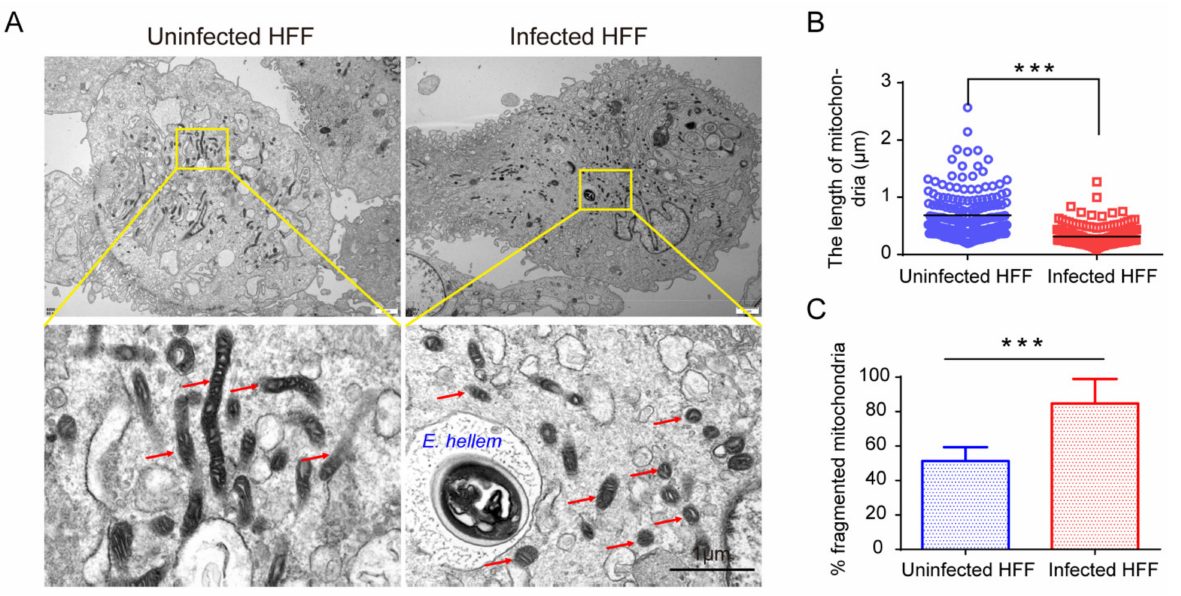
Figure 2. Observation of the HMF by transmission electron microscopy (TEM) in infected cells at 48 hpi. ( A ) TEM shows the HMF (red arrows) in E. hellem -infected HFF cells. The yellow box shows an enlarged view. Bar, 1 µ m. ( B ) Determination of the length changes of mitochondria. At least 150 mitochondria from 10 TEM photographs for each sample were examined. Data of at least three separate experiments were expressed as a scatter plot. ( C ) The percentage of HMF in the uninfected and infected HFF cells. Twelve random cells from 10 TEM photographs for each sample were examined. *** p < 0.001.